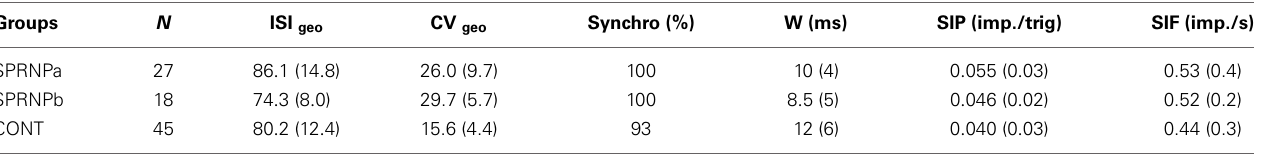
Firing pattern (ISIgeo, CVgeo), rate of significant synchrony (%), peak width and amplitude (W, SIP, SIF) in subsets of 45 MU pairs in patient GL (SPRNPa, SPRNPb) and in control subjects